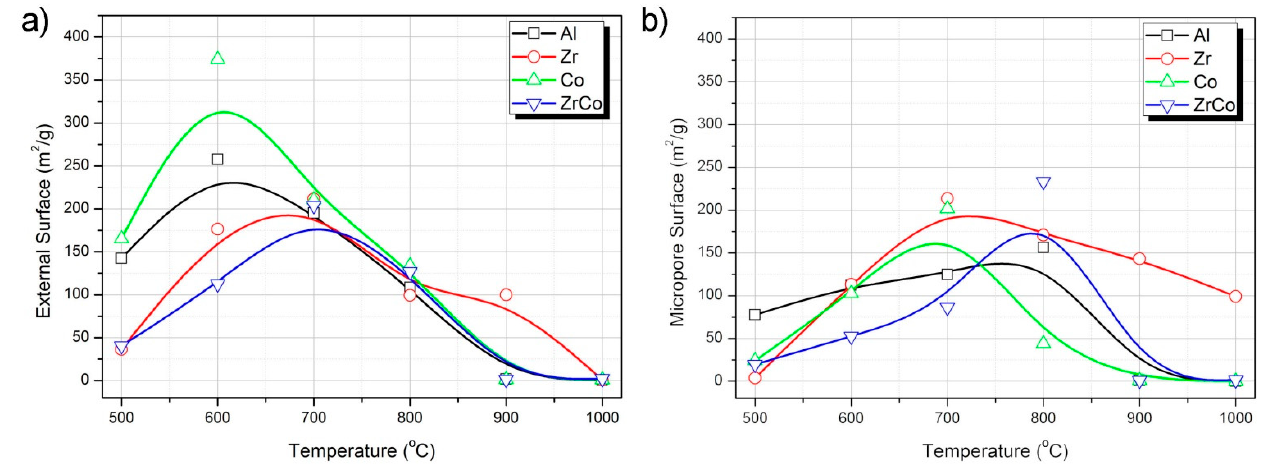
Figure 6. Surface area of the materials corresponding to ( a ) mesopores and ( b ) micropores.